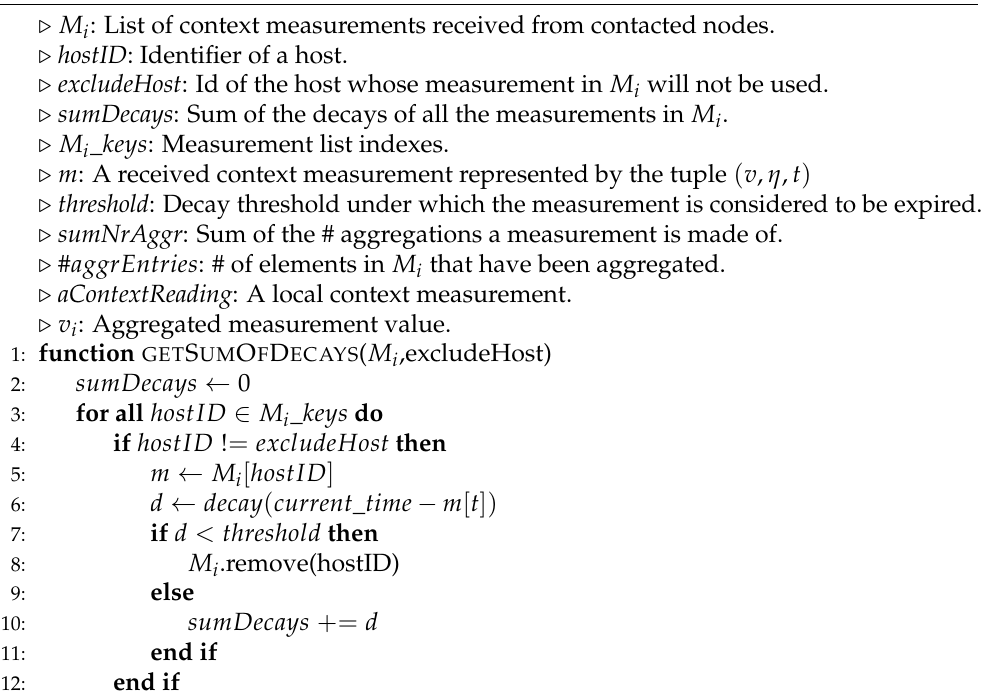
Algorithm 1 Context measurements aggregation